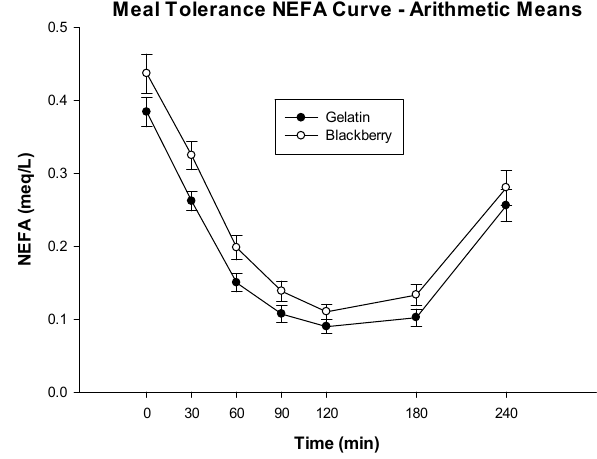
Figure 5. Plasma non-esterified fatty acid concentration as a function of time after administration of the meal-based glucose tolerance test including either blackberries or gelatin. Curves are arithmetic means ± SE. n = 24 subjects.